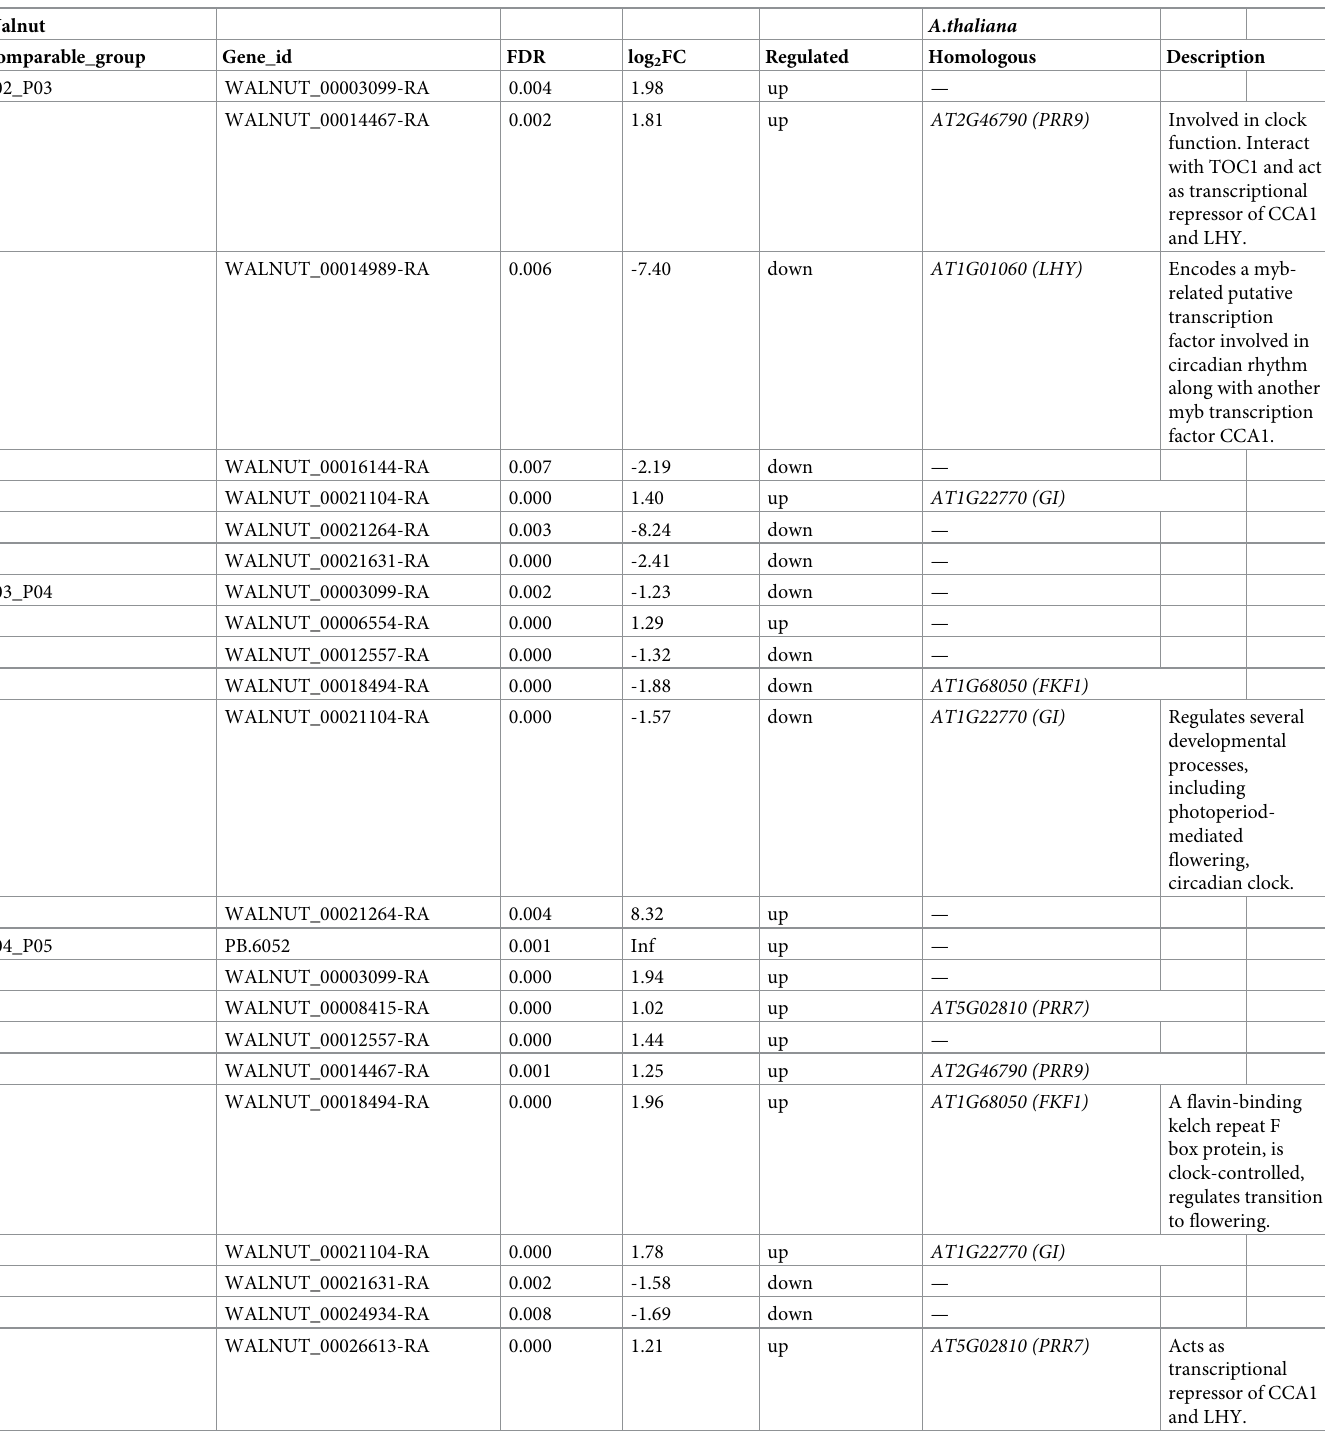
Table 2. List of DEGs related to circadian rhythm-plant pathway in walnut.